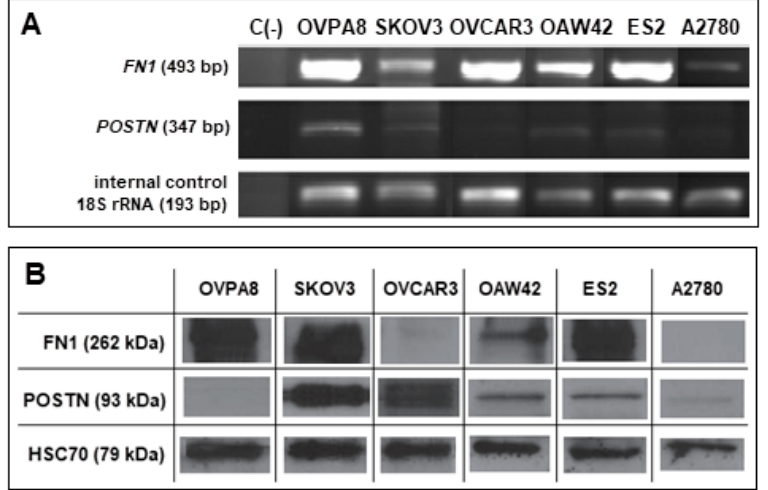
Figure 13. Detection of POSTN and FN1 in OVPA8 and other ovarian cancer cell lines. Gene expression was tested on mRNA level by semi-quantitative RT-PCR ( A ) and at protein level by Western blotting ( B ); C( − )—negative control.